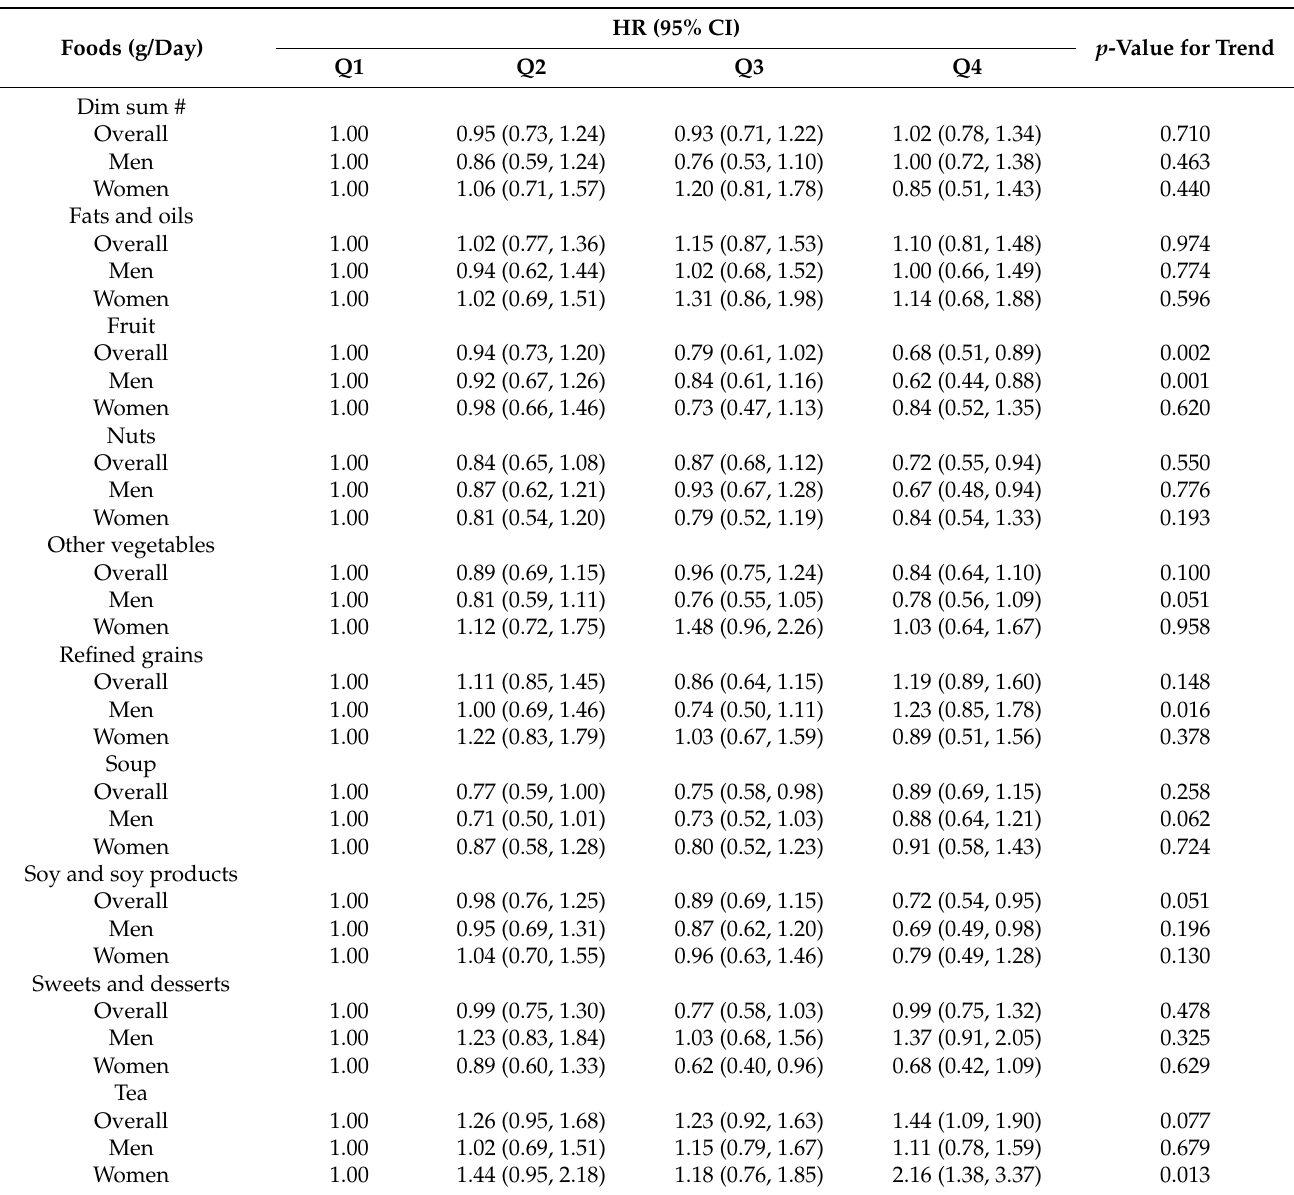
Table 4. Prospective association of the quartile (Q) of food groups with cancer mortality selected by Elastic net regression among participants in the Mr. OS and Ms. OS